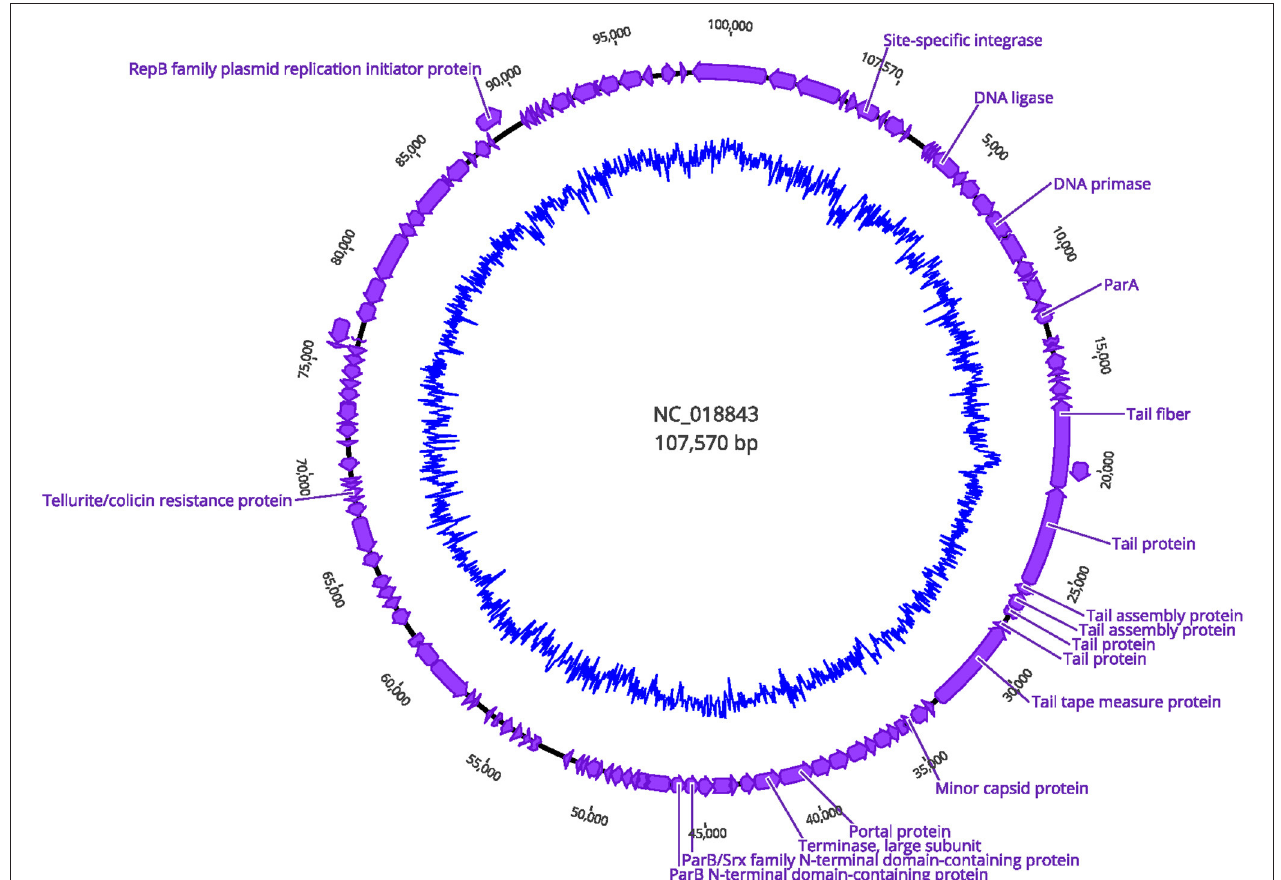
FIGURE 5 | Circular genome visualization of prophage SSU5 identified in SN141 and SN142. Structural genes and genes encoding host genome integration are indicated. Inner circle represents GC content.